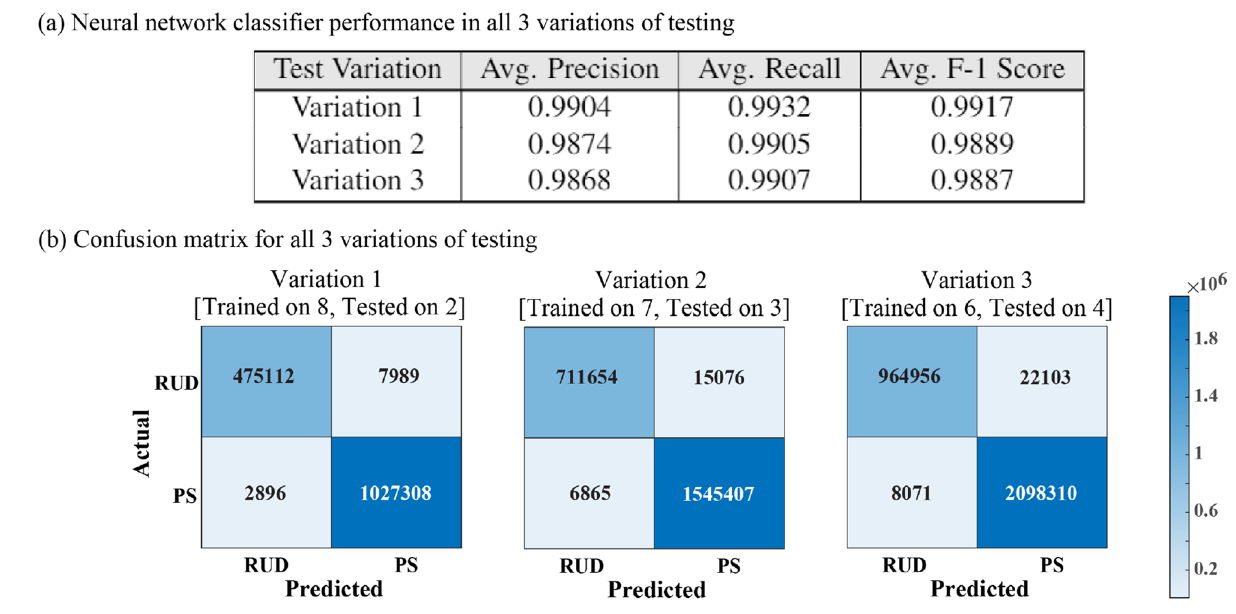
Figure 2. (a) Neural network classifier performance with precision, recall, and F-1 score averaged across all the test sets. Variation 1 involved testing on two unknown participants to the model, variation 2 involved testing on three unknown participants, and variation 3 involved testing on four unknown participants. (b) Confusion matrices depicting the classification performance of neural network models for all 3 variations of testing.